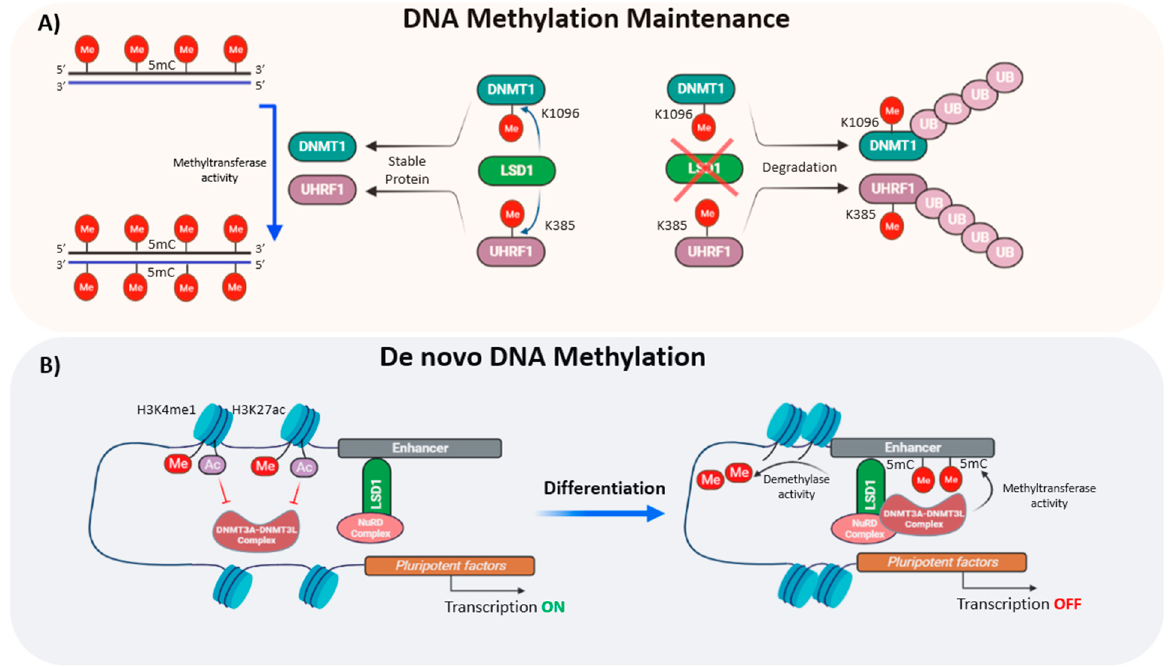
Figure 5. Crosstalk of LSD1 with DNA methylation. ( A ) DNMT1 and UHRF1 are methyltransferases involved in the maintenance of DNA methylation. LSD1 can demethylate DNMT1 and UHRF1 at the positions K1096 and K385, respec- tively, preventing proteasome-mediated degradation and subsequent hypomethylation of the DNA. ( B ) LSD1-mediated demethylation of H3K4me1 at pluripotent enhancers promotes the deposition of 5mC by DNMT3A-DNMT3L, repressing the expression of pluripotency factors during differentiation. In stem cells, H3K27ac inhibits the methyltransferase activity of the DNMT3A-DNMT3L complex.